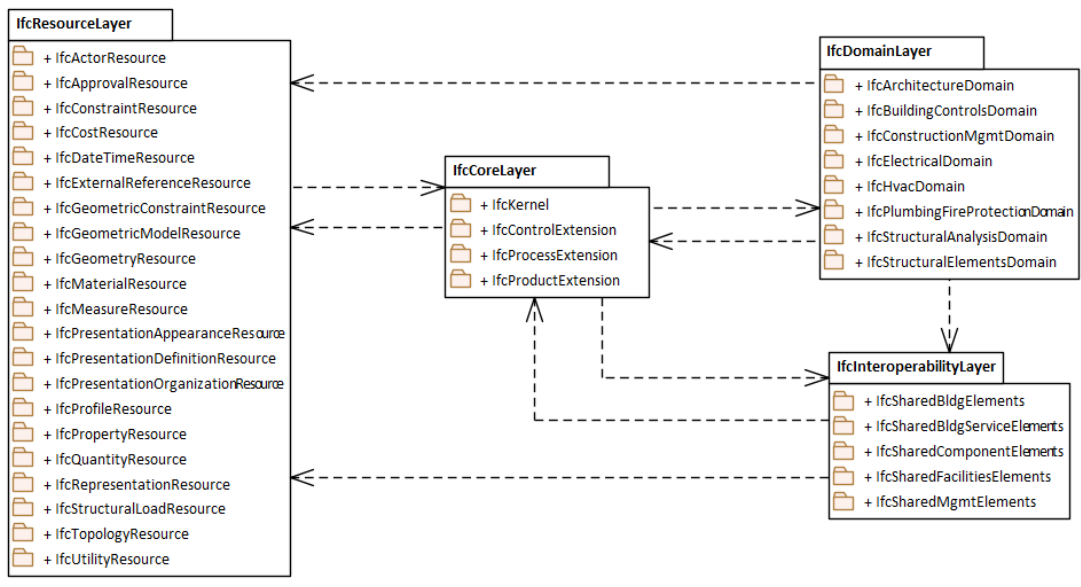
Figure 2. UML package diagram showing the core structure of the IFC-UML Model.